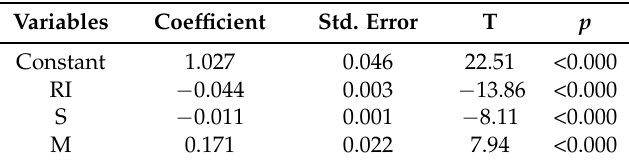
Table 5. Regression coefficient tests for fitting Equation (3).